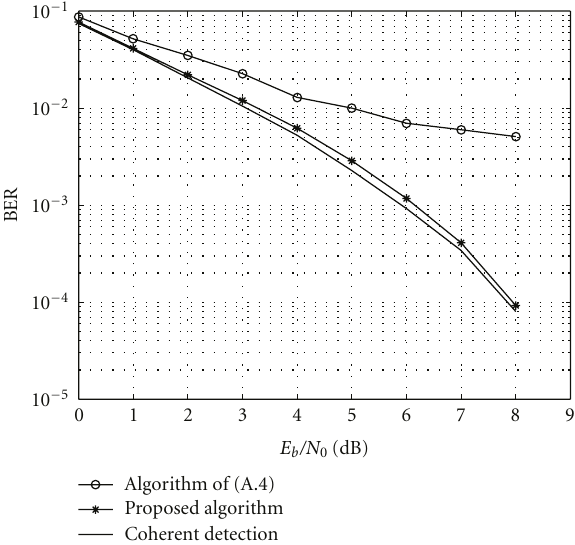
Figure 6: BER curves obtained after estimating the phase o ff set of the system and applying the BP decoder-BPSK modulation.